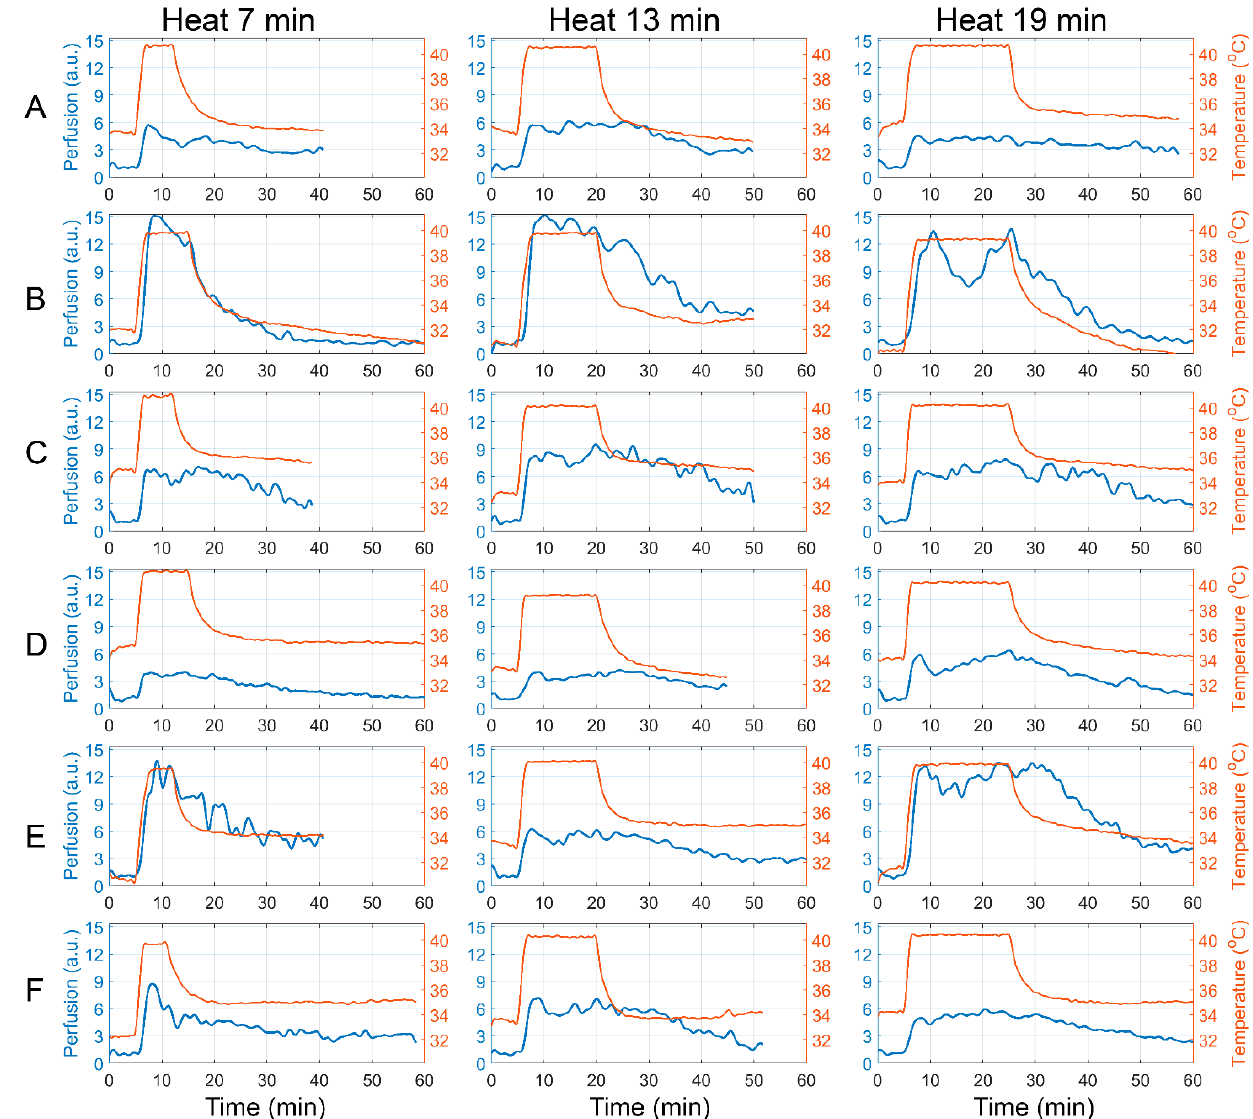
Figure 5. Dynamics of perfusion changes due to subjects’ forearm local heating of different duration. Rows ( A – F ) correspond to different subjects; the columns correspond to the different heating duration indicated in the header of each column. Blue curves show changes in the perfusion index, whereas red curves show changes in local skin temperature. The scales for the perfusion index (as well as for the skin temperature) are the same for all 18 tests. The different duration of local heating is due to the stabilization of indicators after the end of the temperature exposure and individual characteristics of each subject, controlled during the test by a medical specialist. Table 2. Parameters of the perfusion reaction to local skin heating for 7 min.